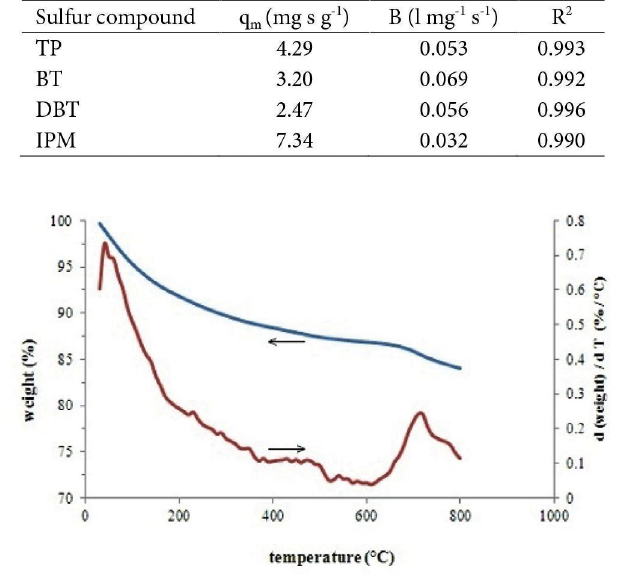
Fig. 10. TGA diagrams of the D1.5 sample initially saturated with